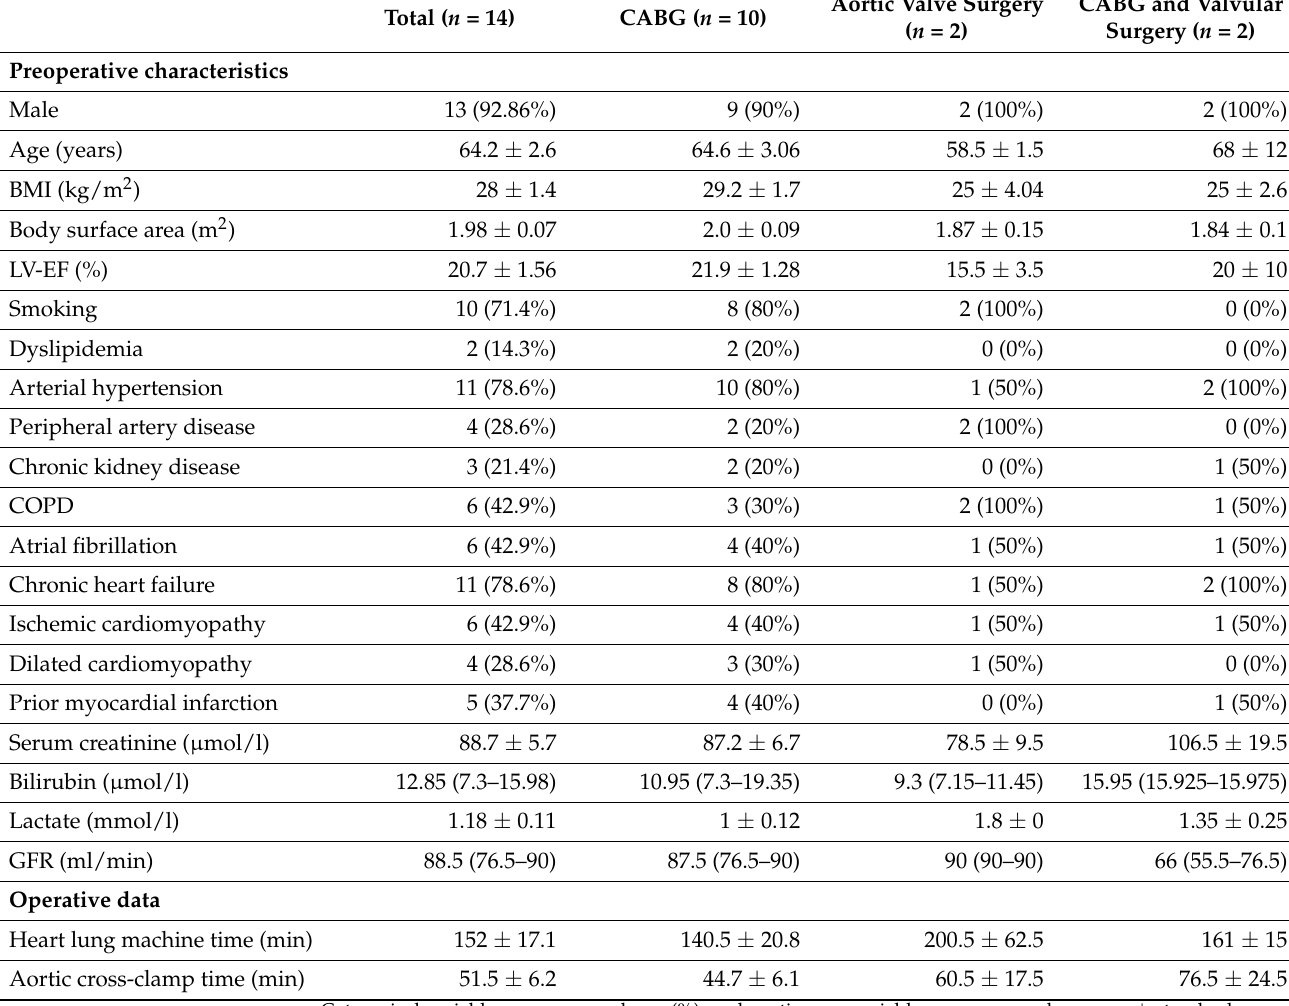
Table 1. Preoperative patient characteristics and operative